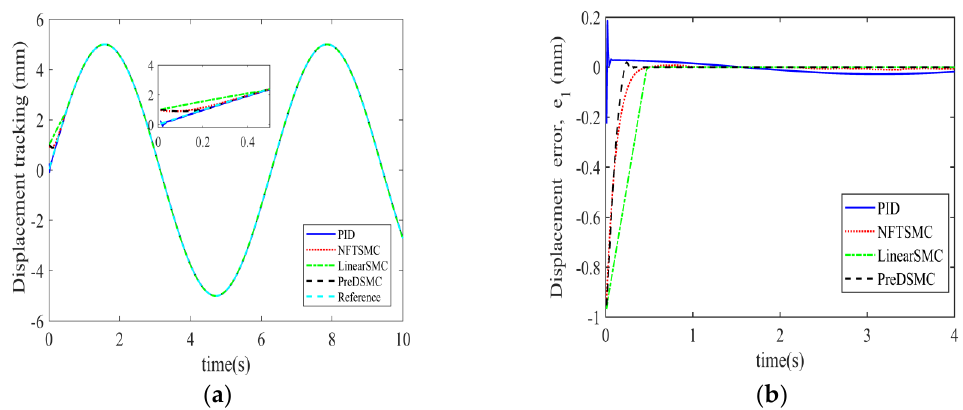
Figure 5. ( a ) Sinusoidal tracking performance of displacement for all control laws. ( b ) The comparison of sinusoidal tracking error of displacement.